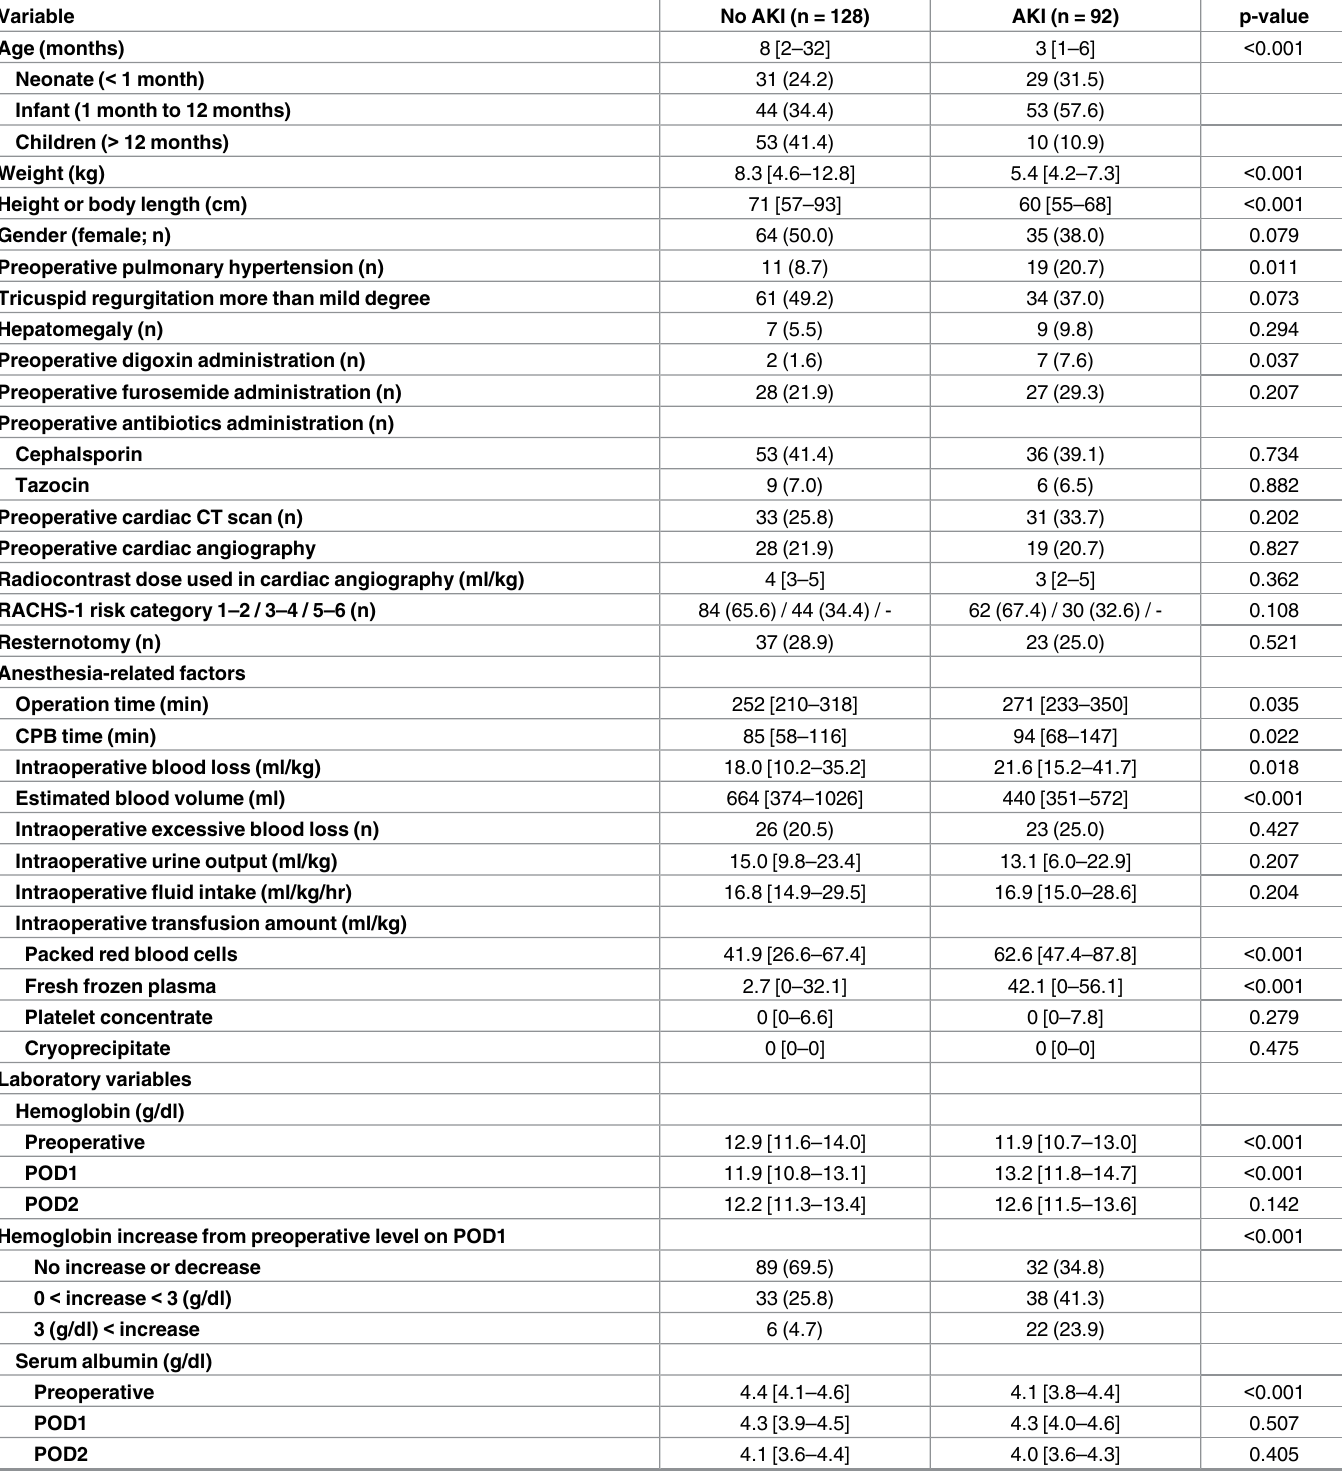
Table 1. Comparison of patient demographics and perioperative clinical parameters between patients with and without postoperative acute kid- ney